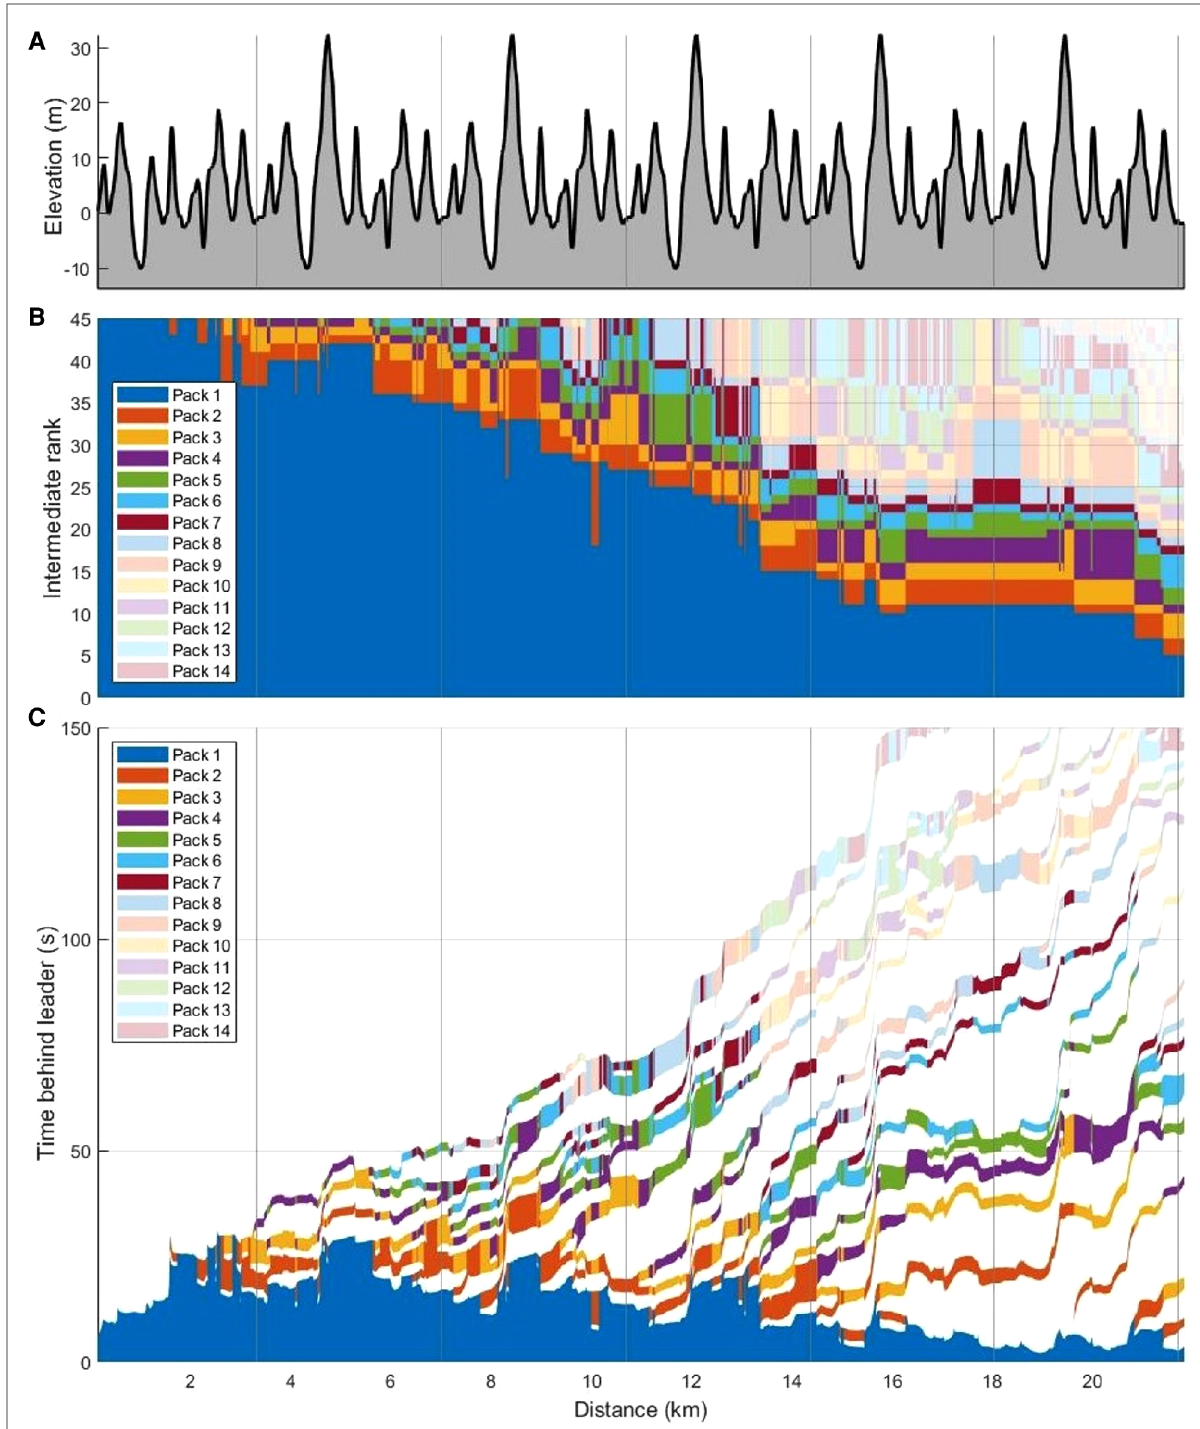
FIGURE 5 Elevation [m] ( A ), intermediate rank of skiers ( B ), and time [s] behind the current leader for each pack ( C ) as a function of distance [km] in a 21.8 km cross-country skiing mass-start competition. A pack of skiers included all consecutive skiers being less than 3 s apart and each pack is highlighted in different